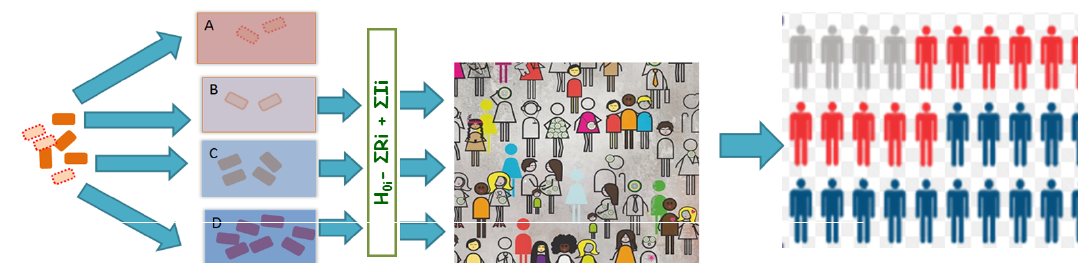
Figure 5. Overview of conclusions: Heterogeneous pathogen events. Pathogen populations (A–D) with stochastically varying phenotypes enter various biotic and abiotic environments. Extreme environments kill pathogens in environment (A), while favorable conditions support vigorous pathogen growth in the environment (D). Intermediate environments support pathogen survival (B) or moderate growth (C). Various surviving pathogen subsets emerging from the various events result in risk variation in an often heterogeneous host population whose susceptibilities vary leading to stochasticity in disease